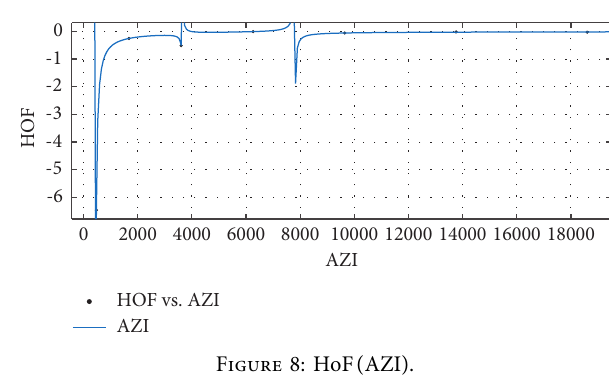
Figure 8: HoF ( AZI ) .